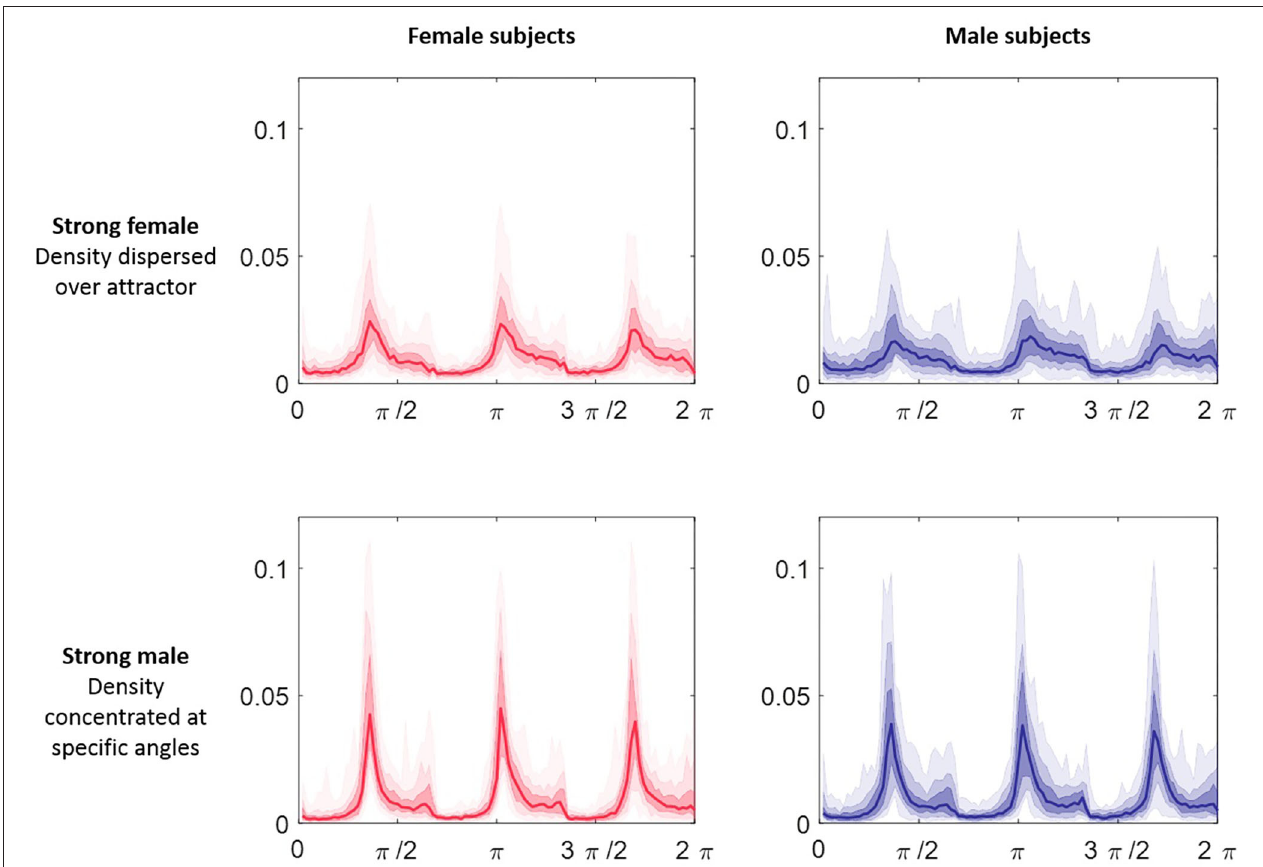
FIGURE 9 | θ density profiles for a 3-point attractor from lead V3 split by sex and classification category. Each plot comprises 50 subjects selected at random from Dataset 2 in the categories of “strong male” and ‘strong female’ respectively. The median of the profiles is shown as the line plot, the first surrounding darker band is the 25th to 75th centiles and then extending out with further bands to cover all the data. The appearance of the profile for the two categories was very different; the “strong male” profile showed sharp density peaks, whereas the “strong female” indicated a more even density distribution across the attractor. We observed that the greatest visual similarity was between subjects of the same category, irrespective of their actual